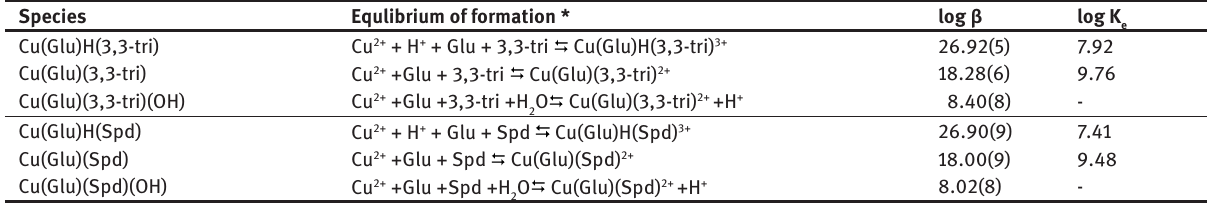
) of complexes formation in Cu(II)/Glu/3,3- tri or Spd systems. e